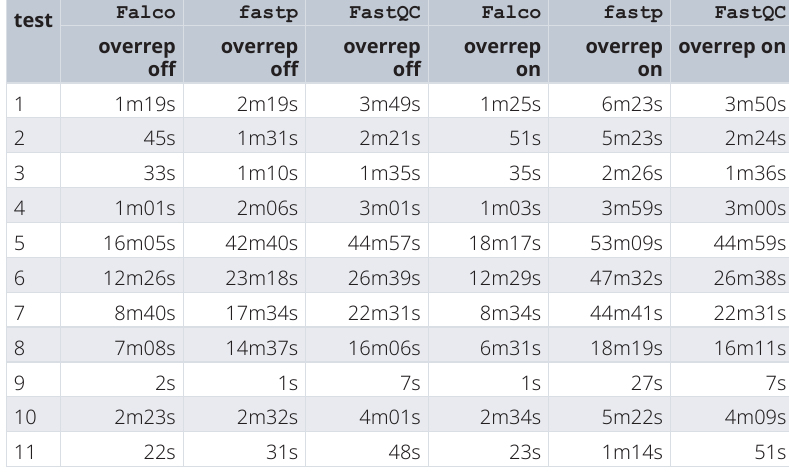
Table 4. Real run times for Falco , fastp and FastQC on gzip compressed FASTQ format.